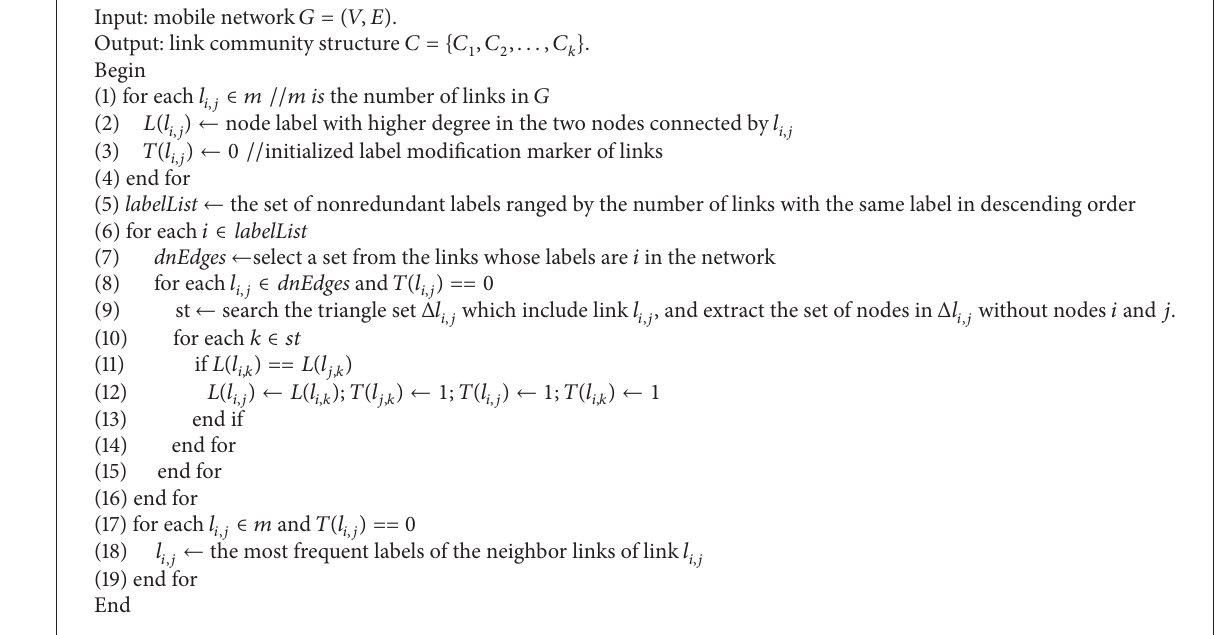
(Figure 1(b) is the line graph structure correspond to the network topology structure of Figure 1(a)) shows that link